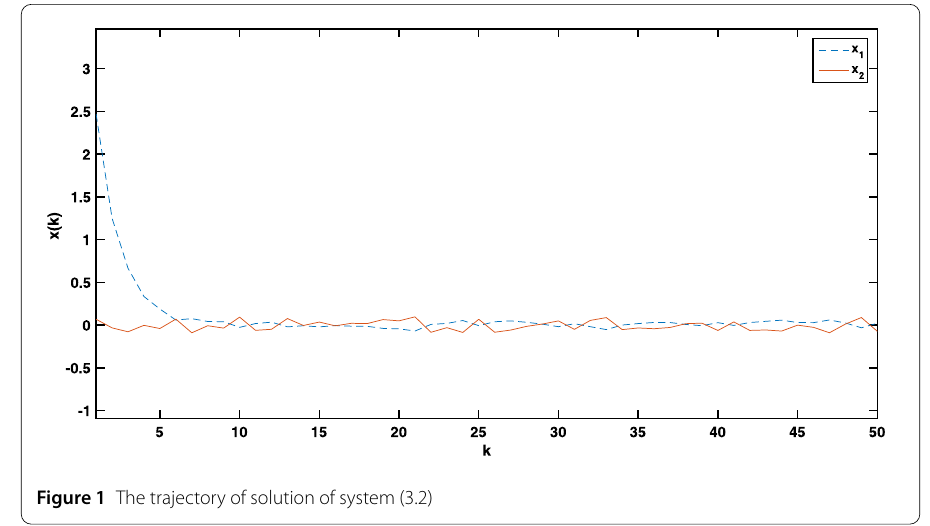
Figure 1 The trajectory of solution of system